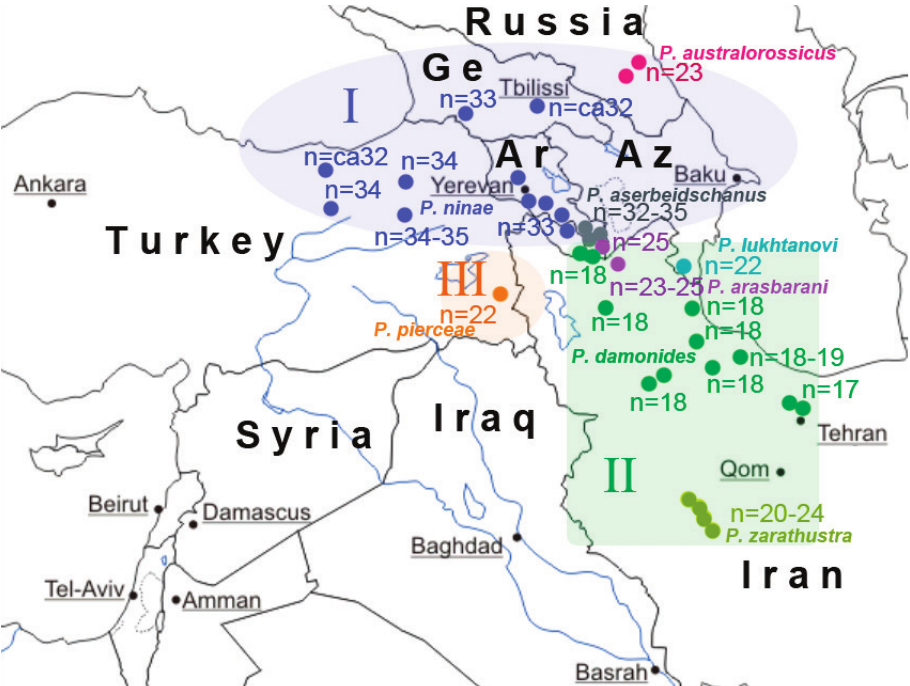
Figure 8. Distribution of COI haplogroups (I – III) and haploid chromosome numbers (n) in the P. damonides species